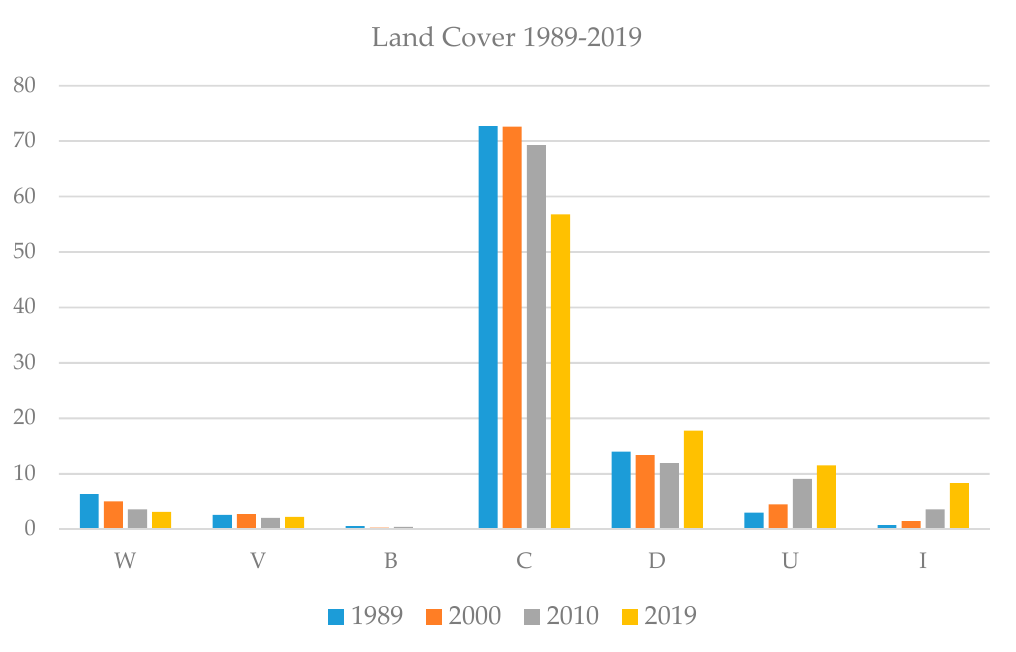
Figure 4. Land use/land cover (LULC) classes (in percentages) in the study area between 1989 and 2019 W: water; B: bare soil; V: vegetated areas; C: cultivated areas; D: discontinuous built-up areas; U: urban areas; I: industries and commercial complexes). Table 4. LULC classes (square kilometers and percentages) in the study area between 1989 and 2019. Land Cover